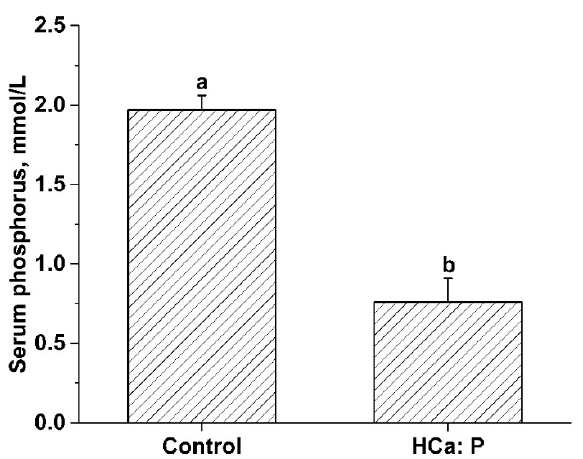
Figure 2. Effect of high-calcium (Ca): phosphorus (P) ratio and P-deficient crumble (HCa:P) feed